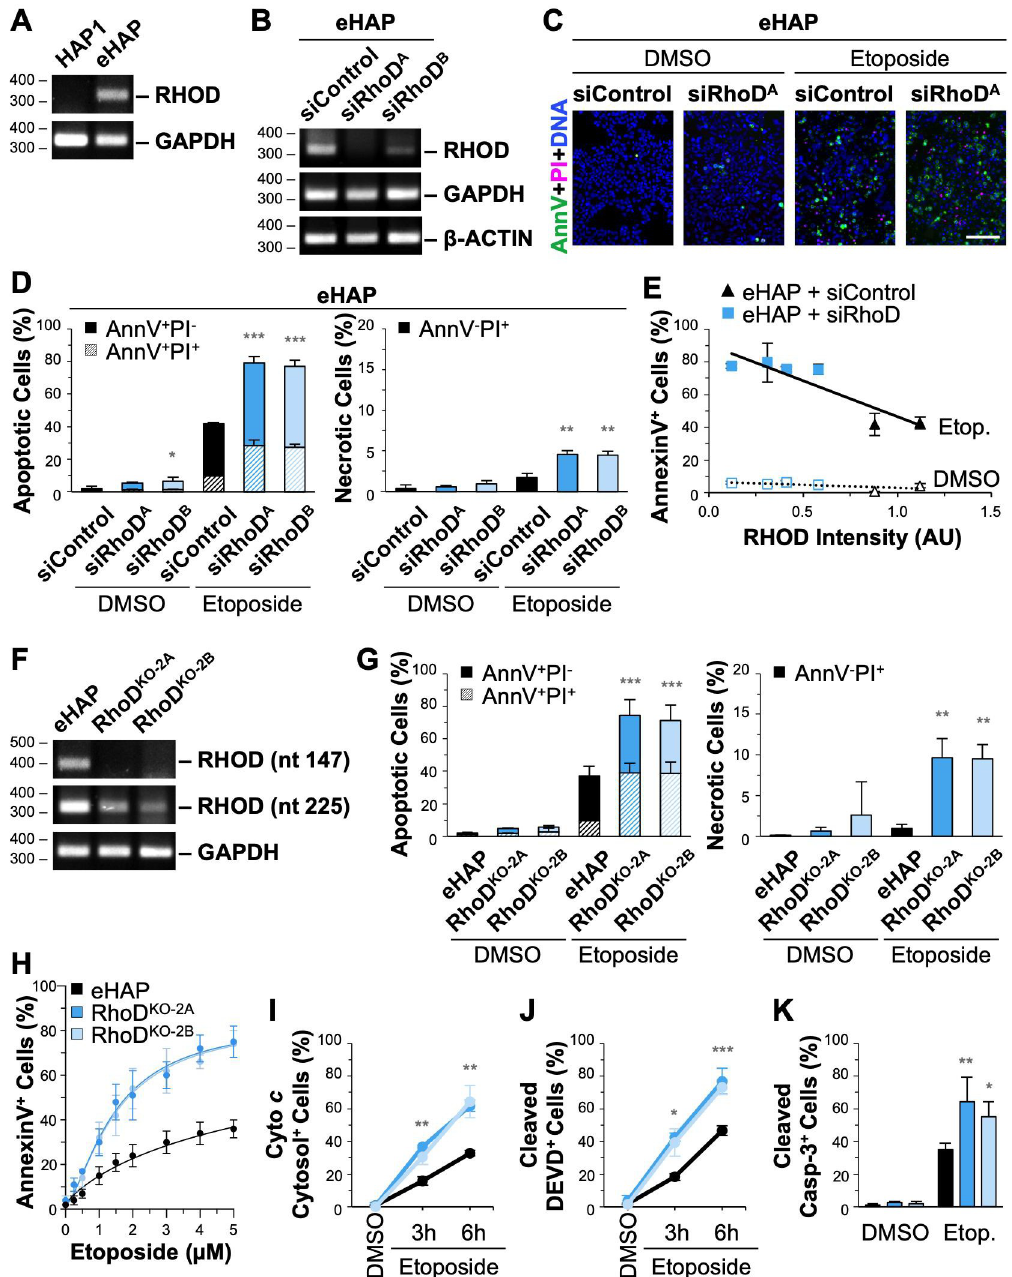
Fig 7. Depletion or deletion of RhoD results in greater levels of apoptotic and necrotic cell death. (A) RNA from HAP1 and eHAP cells was subjected to RT-PCR using primers to RHOD and GAPDH and visualized on agarose gels. (B) eHAP cells were treated with control siRNAs or independent siRNAs for the RHOD gene before performing RT-PCRs with primers to RHOD , GAPDH , and β -ACTIN . (C) Cells were treated with DMSO or 5 μ M etoposide for 6h and stained with Alexa488-AnnV (green), PI (magenta), and Hoechst (blue). Scale bar, 100 μ m. (D) The % of apoptotic cells was calculated and displayed as the fraction of AnnV-positive/PI-negative (AnnV + PI - ) or AnnV/PI double-positive (AnnV + PI + ) cells. Significance stars refer to comparisons of total AnnV + counts for siControl vs siRhoD samples. The % of AnnV-negative/PI-positive (AnnV - PI + ) necrotic cells was also quantified. Significance stars refer to comparisons of siControl vs siRhoD samples. Each bar represents the mean ± SD from 3 experiments (n = 3,662–4,948 cells per sample). (E) RHOD band intensities were normalized to β - ACTIN and plotted versus the % of AnnV-positive cells. Each point represents the mean ± SD from 3 fields-of-view in a given experiment (n = 980–1,728 cells per point). The slopes in the linear trendline regression equations for etoposide-treated samples (Y = -43.48X + 90.28) (p < 0.001, R 2 = 0.75) and DMSO-treated samples (Y = -3.46X + 6.47) (p < 0.01, R 2 = 0.37)